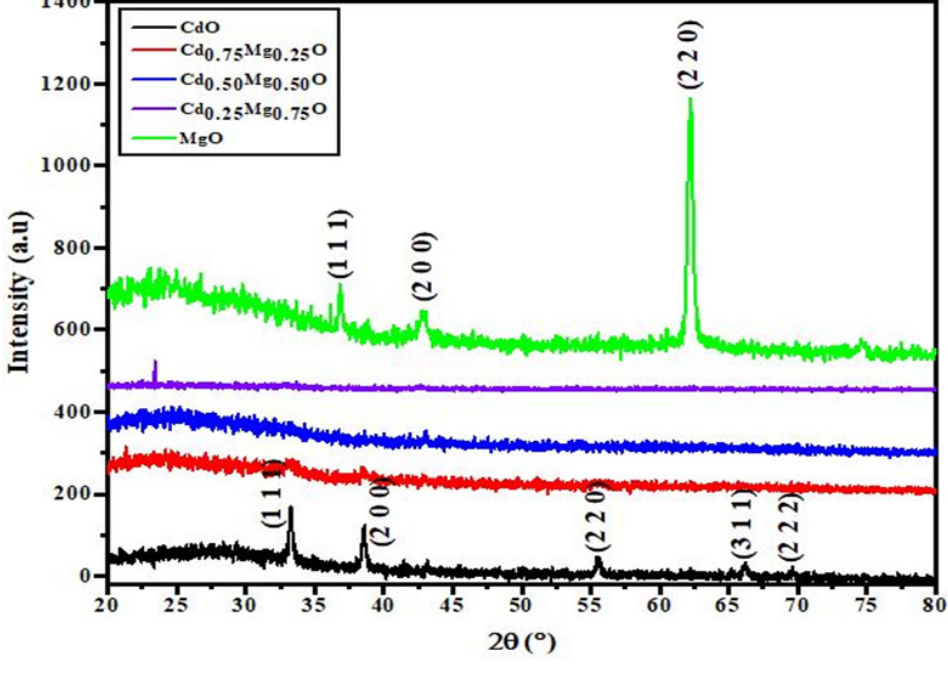
Figure 2. XRD profile of CdO, MgO and CdMgO.